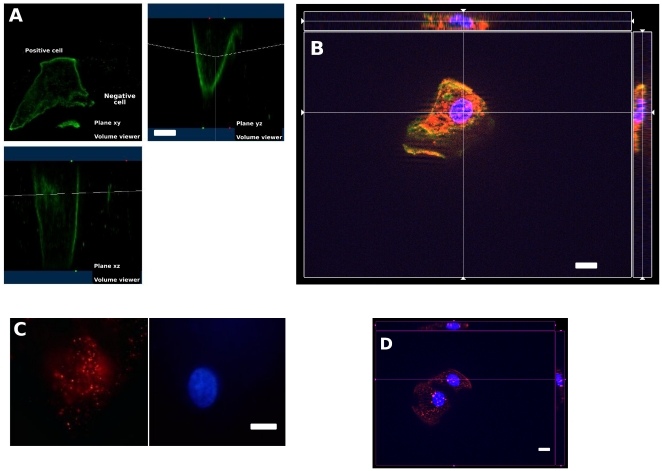
3D-view of exfoliated epithelial cells of preterm infant showing membrane-bound labeling of H+/K+-ATPases (A, B, in green), and intact nuclei labeled by Hoechst (in blue).The cytoplasmic expression of Survivin (B, red), LC3-b (C, red) and CLOCK (D, red). White bars stand for 10 µm.